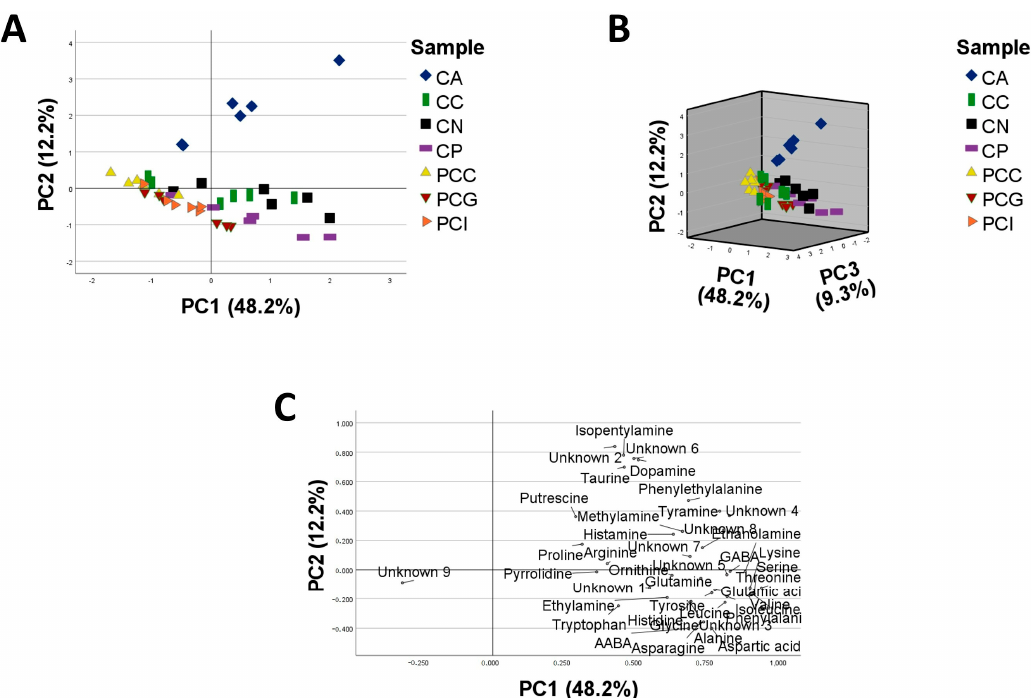
Figure 2. Principal Component Analysis (PCA) of 42 Cardueae samples (six individuals for each species/locality) based on peak areas in NL scan mode of 41 informative compounds selected as variables: ( A ) score plot of the first principal component against the second component, ( B ) 3D score plot of the first, second and third principal components ( C ) loading plot of the